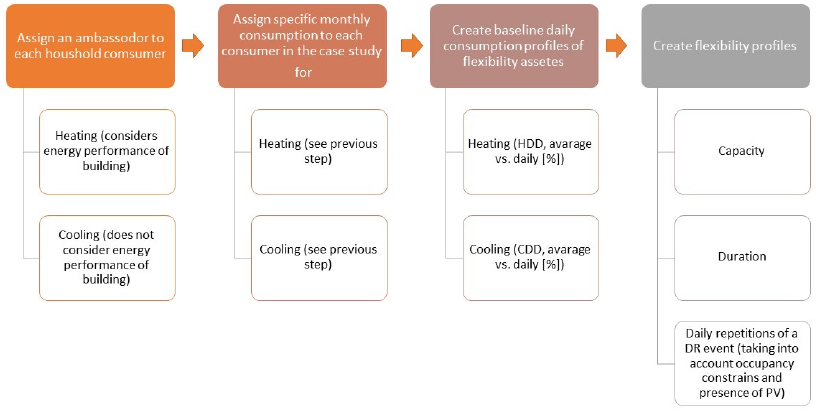
Figure 5. Methodology for aggregator flexibility asset modelling—monthly to daily baseline assess- ment and activation strategies.